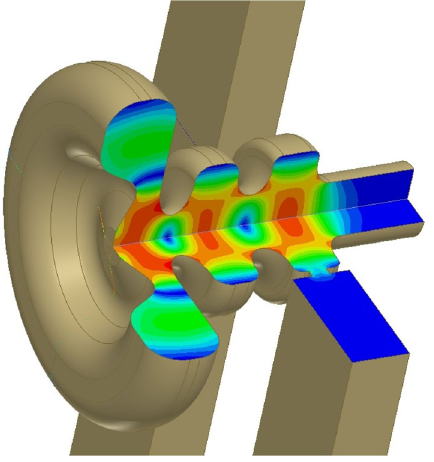
FIG. 10. Geometry of the CTF gun No. V, with magnitude of the electric field in the horizontal and vertical